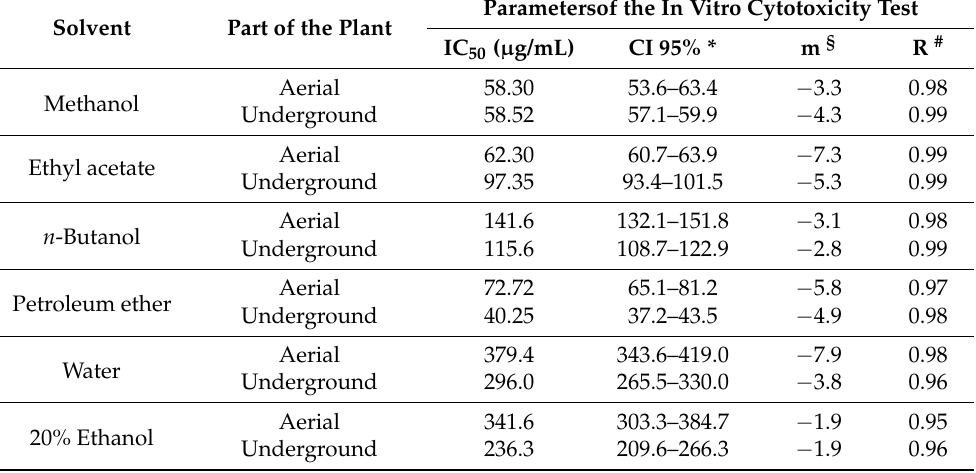
Table 1. In vitro cytotoxicity of G. urbanum extracts on the non-tumorigenic cell line HEK293 after 72 h of incubation.